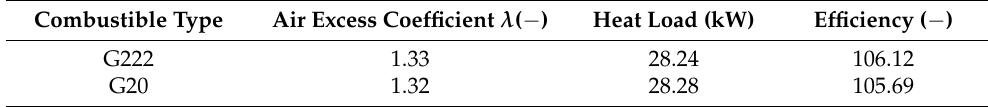
Table 7. Performance indicators for the 50/30 ◦ C condensation